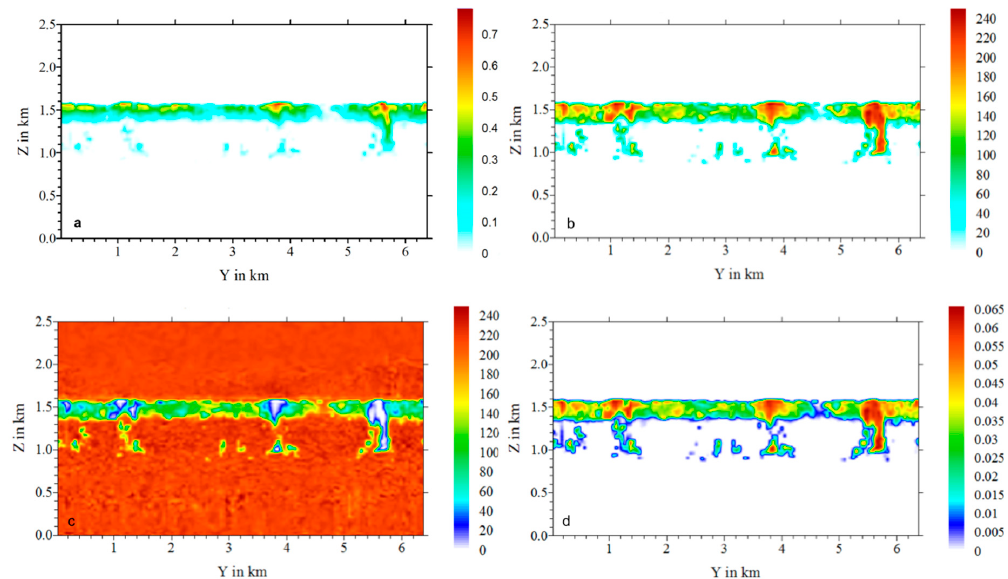
Figure 4. Vertical cross section of ( a ) the liquid water content (g cm − 3 ), ( b ) the number of drops (cm − 3 ), ( c ) the number of aerosol particles (cm − 3 ) and ( d ) the aerosol particle mass inside the drops (µg m − 3 ) after 200 min along the cross section indicated in Figure 3a and projected onto the Y-axis.